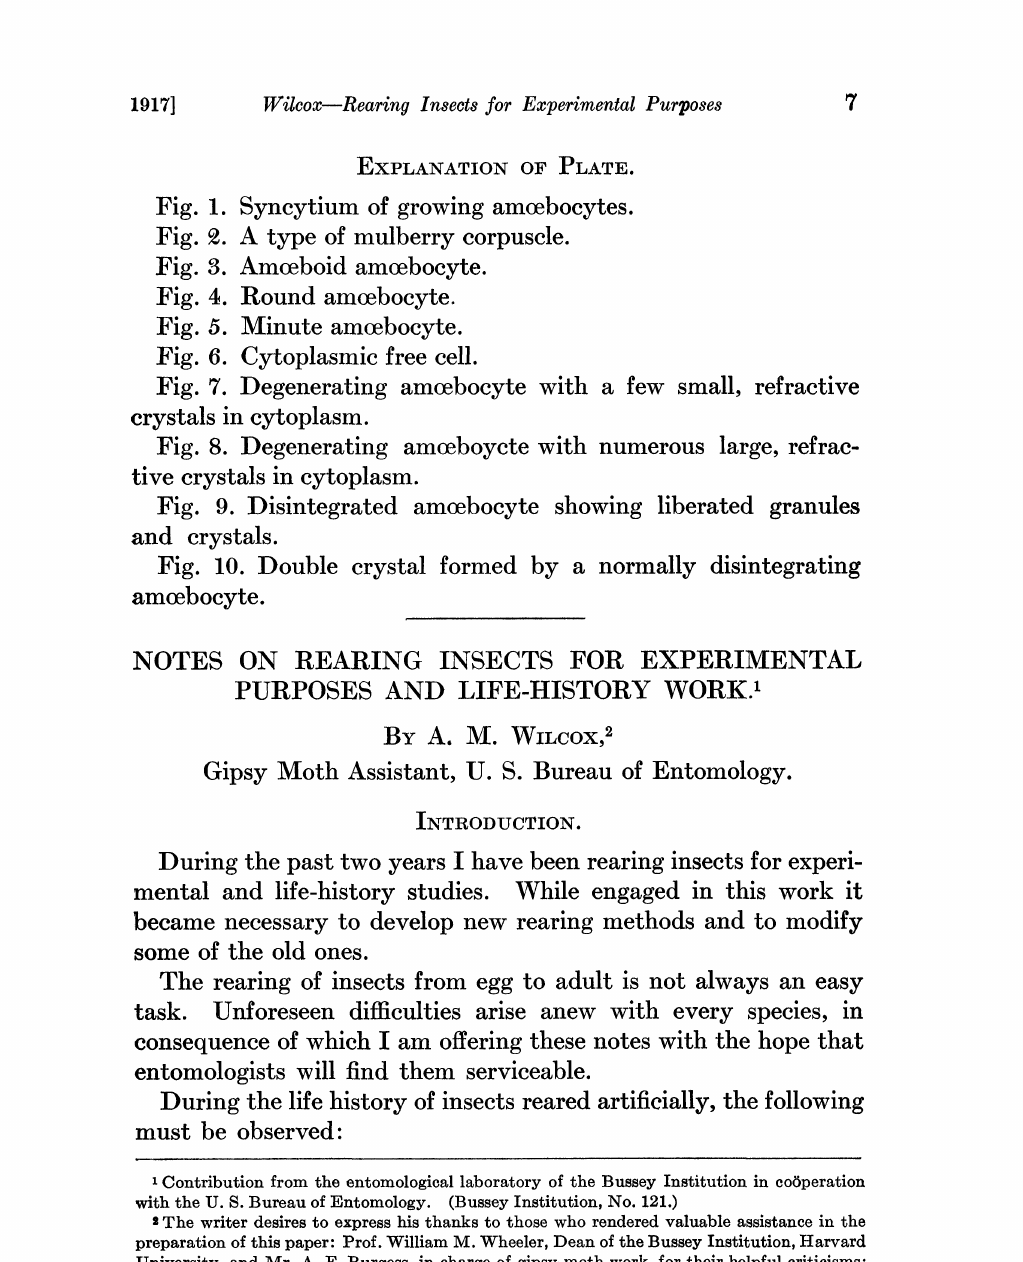
. Fig. 1. Syncytium of growing amcebocytes. A type of mulberry corpuscle. Fig. Fig. 3. Amoeboid amebocyte. Fig. 4. Round amcebocyte. Fig. 5. Minute amcebocyte. Fig. 6. Cytoplasmic free cell. Fig. 7. Degenerating amcebocyte with a few small, refractive crystals in cytoplasm. Fig. 8. Degenerating amceboycte with numerous large, refrac- tive crystals in cytoplasm. Fig. 9. Disintegrated amcebocyte showing liberated granules and crystals. Fig. 10. Double crystal formed by a normally disintegrating